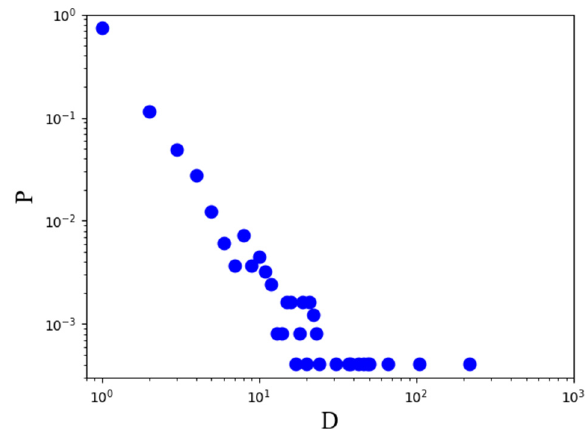
Figure 1. Keyword frequency distribution in neuroscience in the field of education.